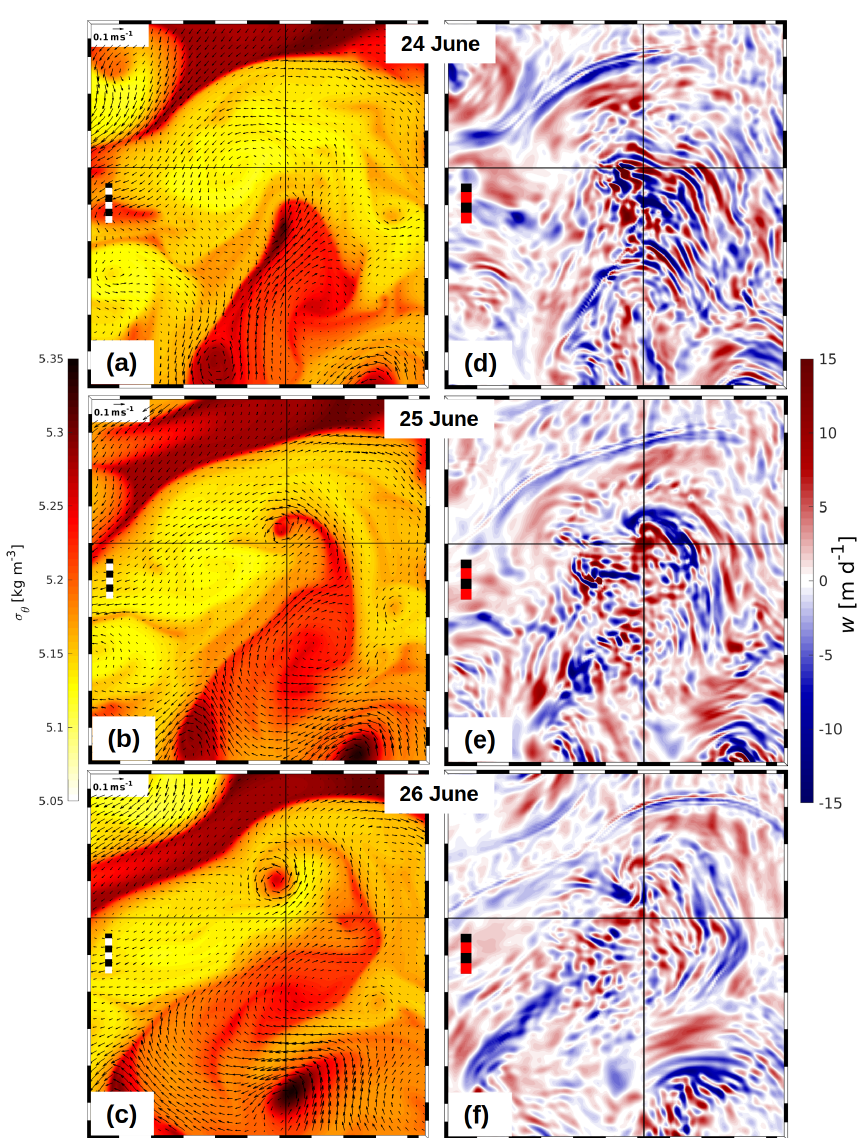
Figure 12. R100: (a) – (c) temporal evolution of a potential density anomaly σ θ in the top layer with vectors of total velocity V drawn at 400m resolution and (d) – (f) corresponding vertical velocity w at 5m of depth; upwelling is positive. The area shown is indicated by the blue box in Fig. 7a. The cross hairs tag the same position in all subplots.The dashed rulers represent a distance of